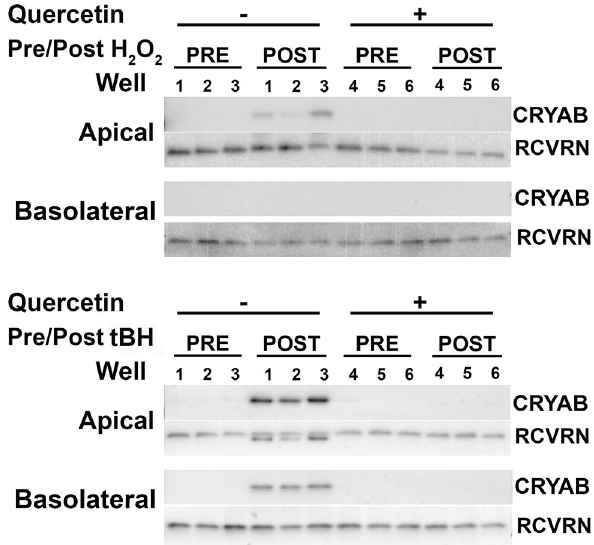
Figure 5. H 2 O 2 - and tBH-induced oxidative stress increase RPE polarized CRYAB secretion. Western blot shows CRYAB in apical and basolateral conditioned media before (PRE) and after (POST) incubation with ( A ) 800 µM H 2 O 2 for 24 h, or ( B ) 1 mM tBH for 6 h, with or without pre-treatment with quercetin. As there is no endogenous protein suitable for normalization between apical and basolateral samples, equal amounts of recoverin (RCVRN) were spiked into samples and used as controls. N = 3. Cropped blots are shown. Uncropped images are in Supplementary Fig.